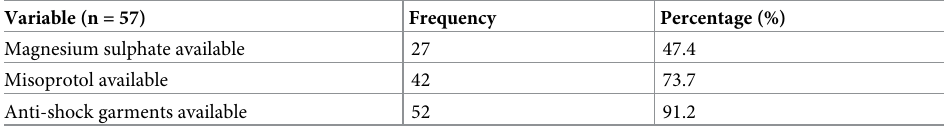
Table 7. Availability of the technologies at the flagship PHCs in Lagos state.